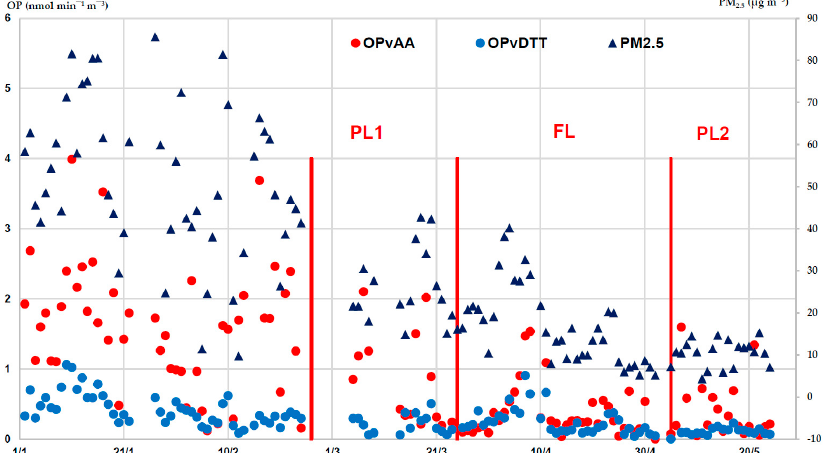
Figure 2. Temporal evolution along the whole investigated time of the extrinsic volume-based OP AAV (red points, left Y scale) and OP DTTV (light blue points, right Y scale) responses and PM 2.5 concentrations (blue triangles, right Y scale). The vertical lines indicate the first day of each lockdown period, namely 26 February for PL1, 25 March for FL and 5 May for PL2.